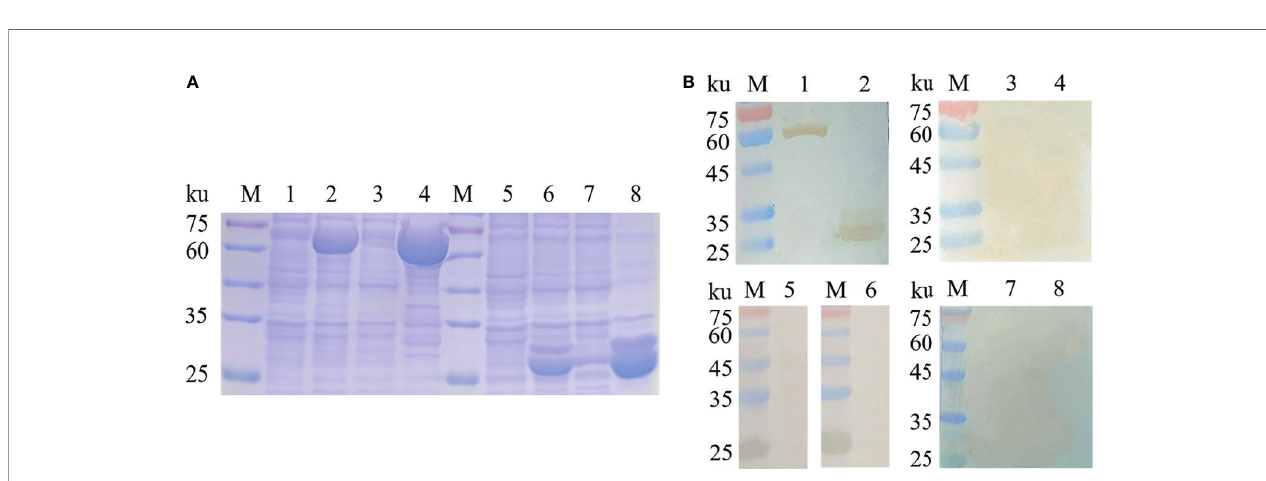
FIGURE 6 | Expression and antigenicity analysis of Myof1 and Myof2. (A) The recombinant proteins, Myof1 and Myof2, were subjected to SDS-PAGE (12% gel). M: standard molecular size; Line 1: Un-induced recombinant Myof1-C/BL21; Line 2: Induced recombinant pET-32a-Myof1-C/BL21 with IPTG; Lines 4-5: Supernatant and precipitate of the expression product from the recombinant pET-32a-Myof1 with IPTG induction, respectively. Line 5: Un-induced recombinant Myof2-C/BL21; Line 6: Induced recombinant pET-32a-Myof2-C/BL21 with IPTG; Lines 7-8: Supernatant and precipitate of the expression product from the recombinant pET-32a- Myof2 with IPTG induction, respectively. (B) The recombinant proteins reacted with different sera. M: standard molecular size; Lines 1-2: The recombinant proteins, Myof1 and Myof2, incubated with positive sera of the rabbit infected with C sinensis ; Lines 3-4: Negative serum of rabbit as a control. Lines 5-6: The recombinant proteins, Myof1 and Myof2, incubated with positive sera of the rabbit infected with S. japonicum . Lines 7-8: The recombinant proteins, Myof1 and Myof2, incubated with positive sera of the rabbit infected with F. hepatica .